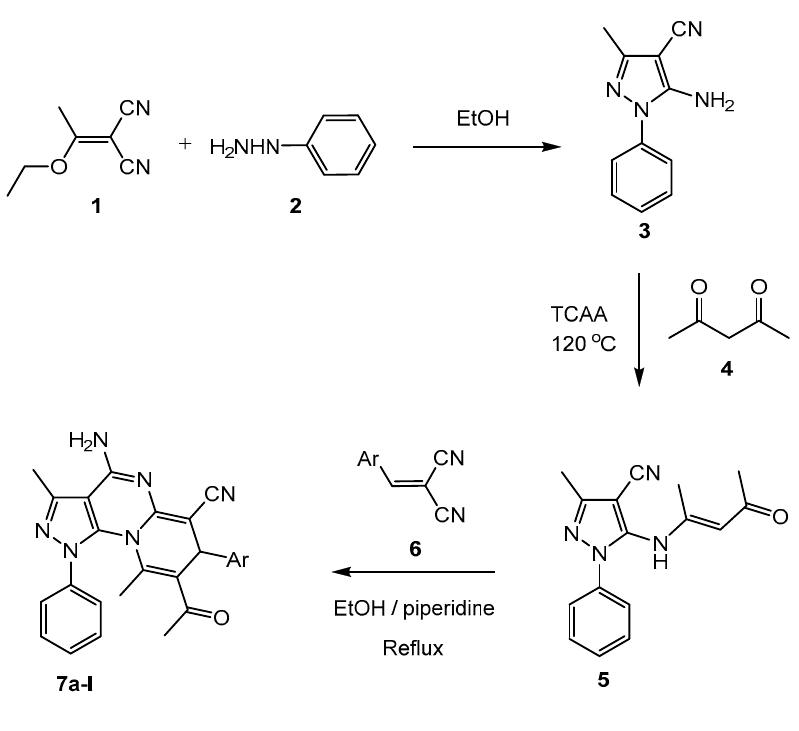
Scheme 1. Synthetic pathway for the synthesis of pyrazolo-pyrido-pyrimidine derivatives 7a – l